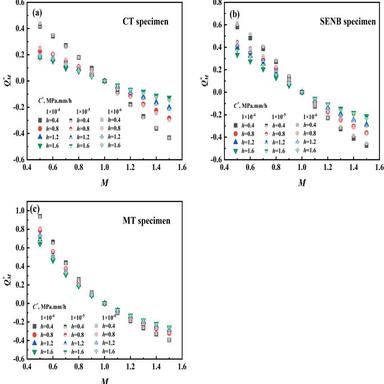
The Q∗ Mvalues for (a) CT, (b) SENB and (c) MT specimens at all mismatch levels at C \ = 1× 10− 4 , 1 × 10− 5 , 1 × 10− 6 MPa.mm/h.